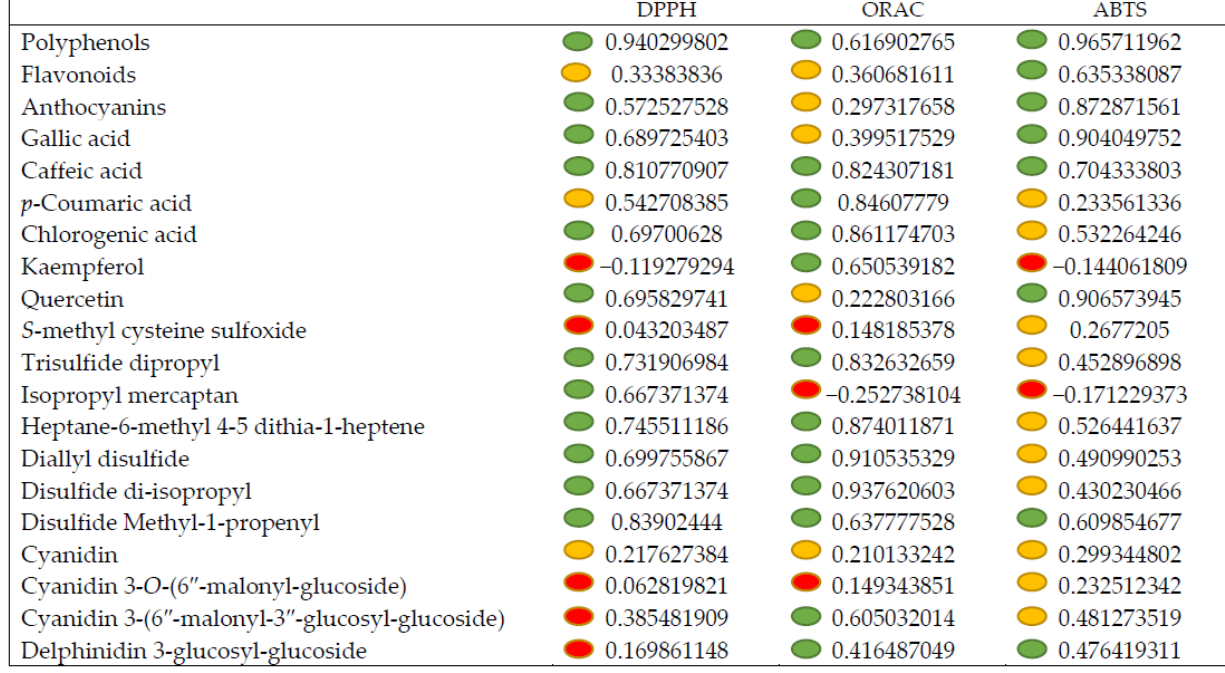
Figure 4. Pearson’s correlations (r) between phytochemicals and antioxidant activities. The boxed dots show the significant correlations between values; the color shows the level of correlation (yellow boxed dots p < 0.05 and green boxed dots p < 0.01). The red dots indicate a negative correlation.